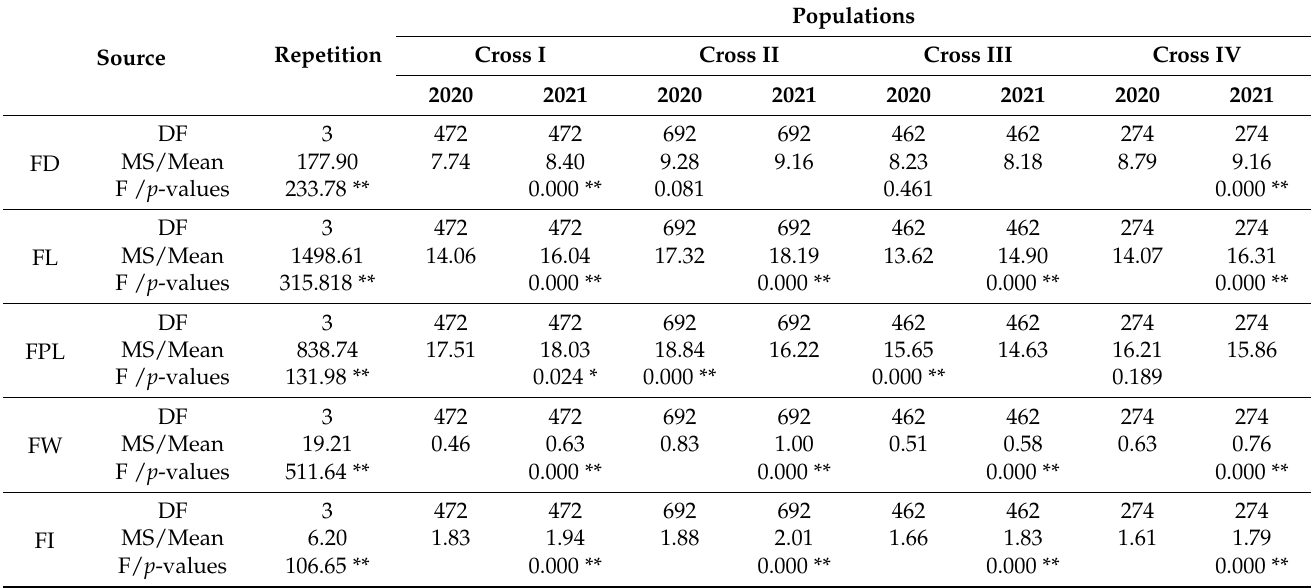
Table 2. Complex variance analysis of the main fruit characteristics in F 1 hybrids from four crosses.